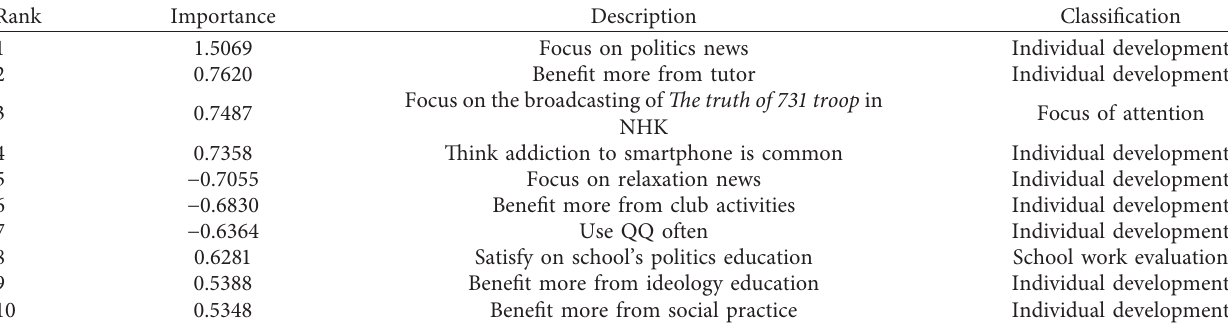
Table 1: Feature